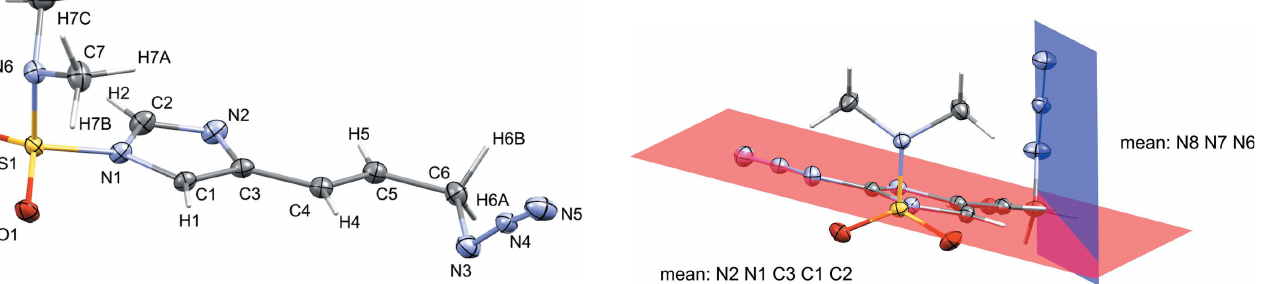
Figure 1 The molecular structure of compound 1 , with atom labels and 50% probability displacement ellipsoids for non-H atoms.